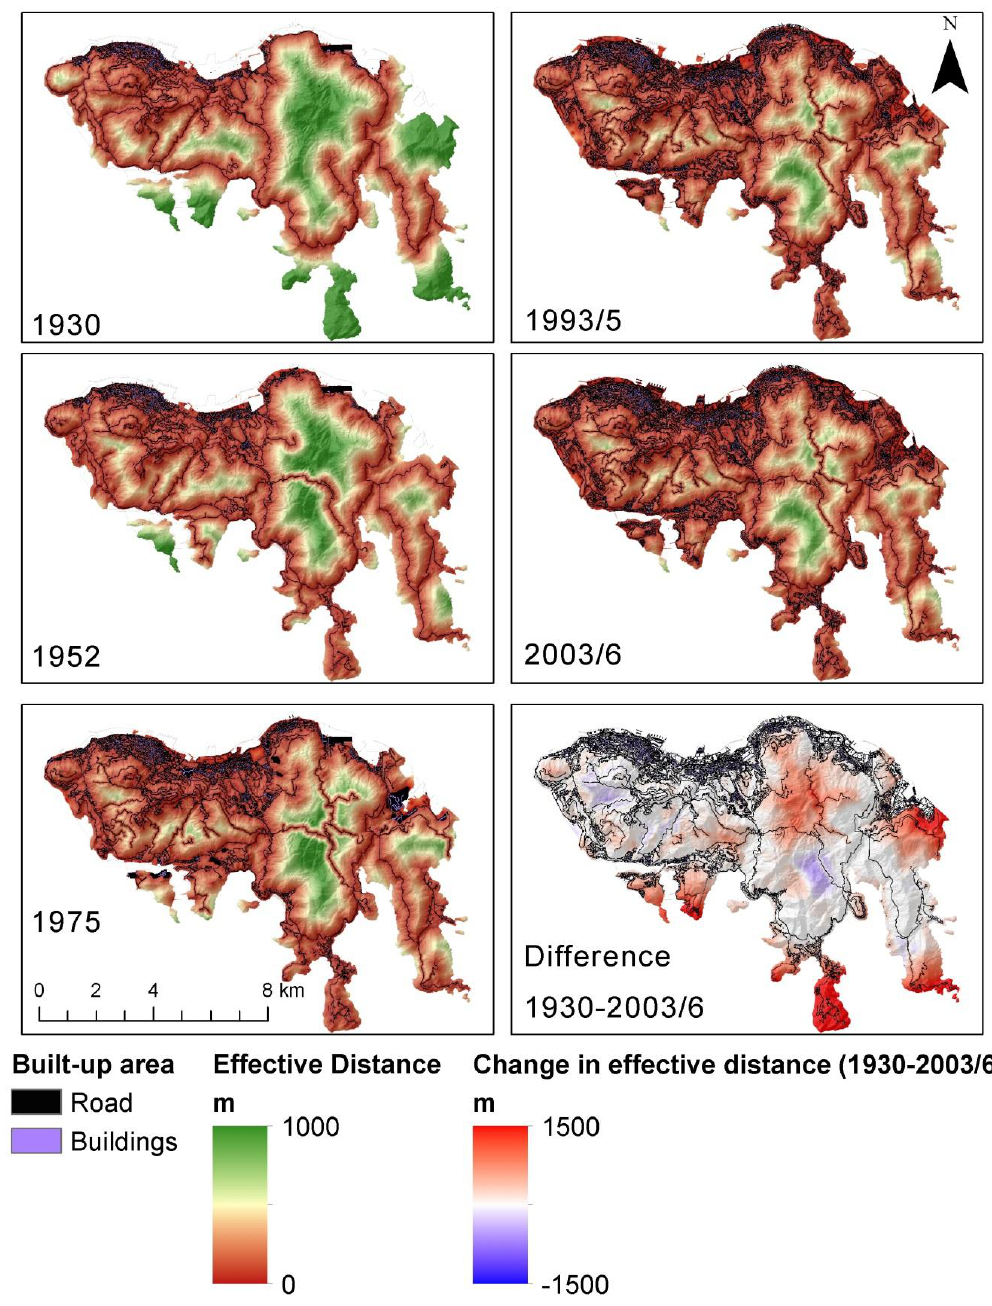
Figure 5. Changes in landscape continuity on Hong Kong Island. Five panels show landscape continuity values calculated based on the roads network and buildings (1930, 1952, 1975, 1993/5, 2003/6); the lower-right panel presents changes in landscape continuity between 1930 and 2003/6, with warm hues (positive values) signifying a decrease in landscape continuity over time (calculated by subtracting the 2003/6 effective distances layer from the 1930 effective distances